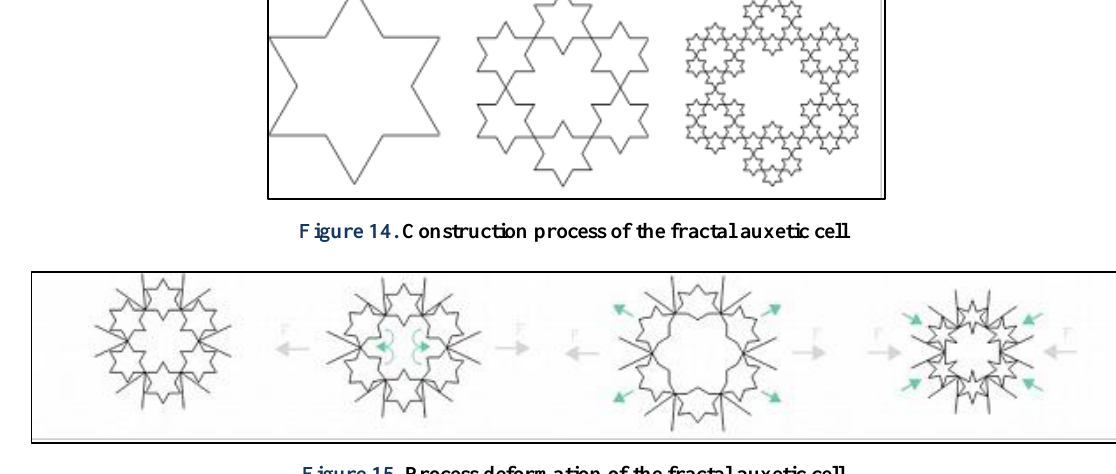
Figure 15. Process deformation of the fractal auxetic cell